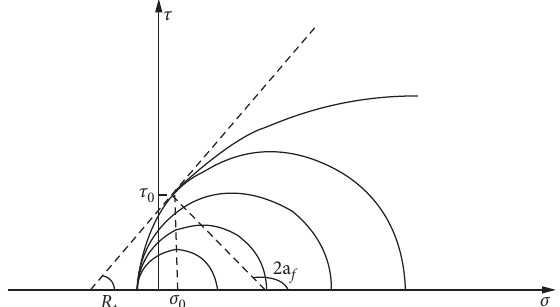
Figure 5: Double-parameter parabolic strength curve and stress